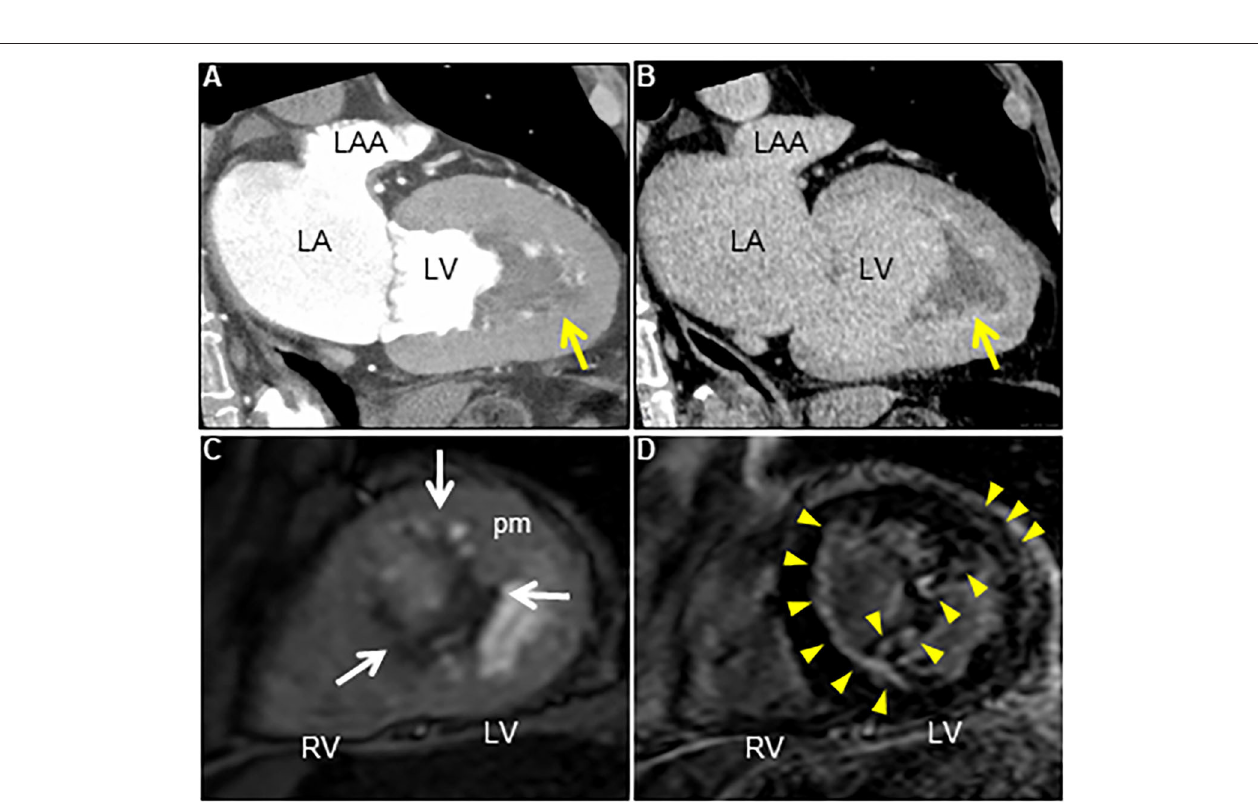
FIGURE 3 | (A) Contrast-enhanced computed tomography scan at early phase reveals an irregular cardiac mass attached to the left ventricle in several locations (arrow). (B) Note the reduced mass with a delayed contrast enhancement at late phase (arrow). (C) Axial dynamic cardiac magnetic resonance imaging reveals a low echogenic left ventricular mass attached to the anteroseptal and inferior walls, and the anterolateral papillary muscle (arrows). (D) Late gadolinium enhancement image reveals subendocardial enhancement in anteroseptal and inferior walls, mid-wall enhancement in lateral wall, and heterogeneous enhancement within the cardiac mass and the adjacent anterolateral papillary muscle (arrowheads). LA, Left atrium; LAA, Left atrial appendage; LV, Left ventricle; pm, Papillary muscle; RV, Right ventricle.